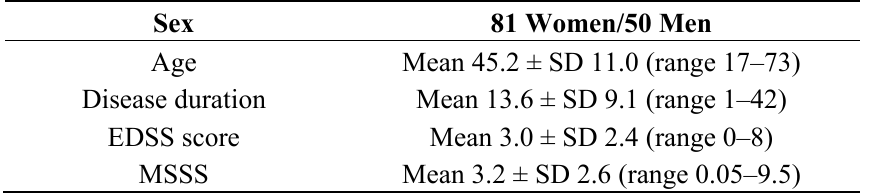
Table 1. Demographic and Clinical Features of 131 MS Patients.